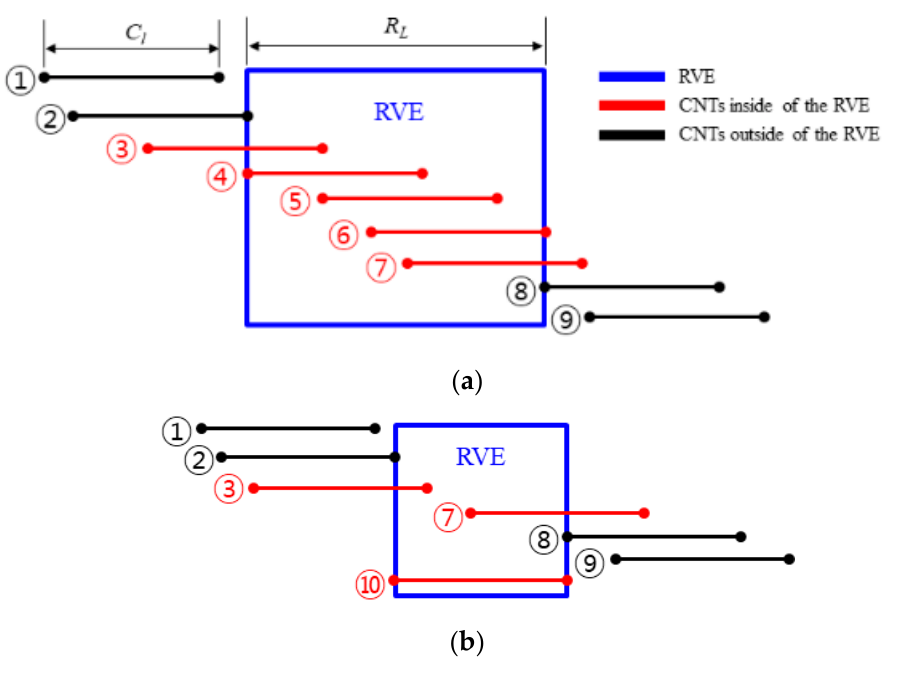
= C l and ( b ) R L l